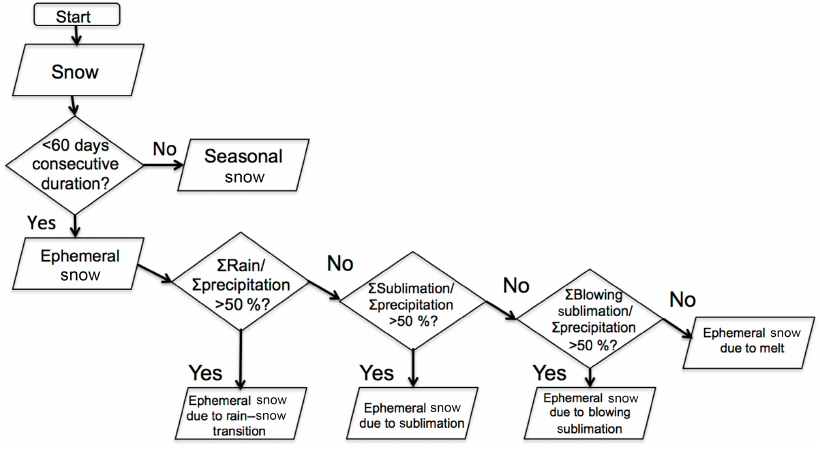
Figure 2. Diagram of the process for the ephemeral snow mechanism model. Seasonal snow outputs were rejected, and all other outputs were